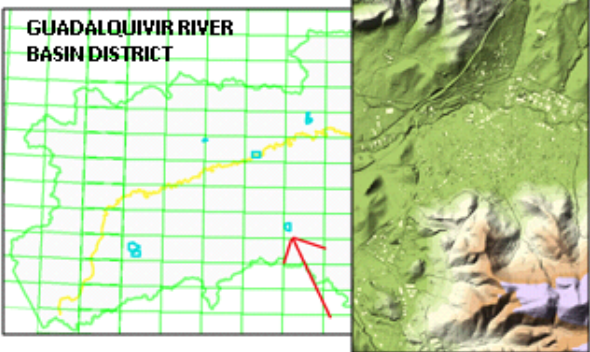
Figure 1. Urban test area (Lucena urban area in Córdoba, Spain).